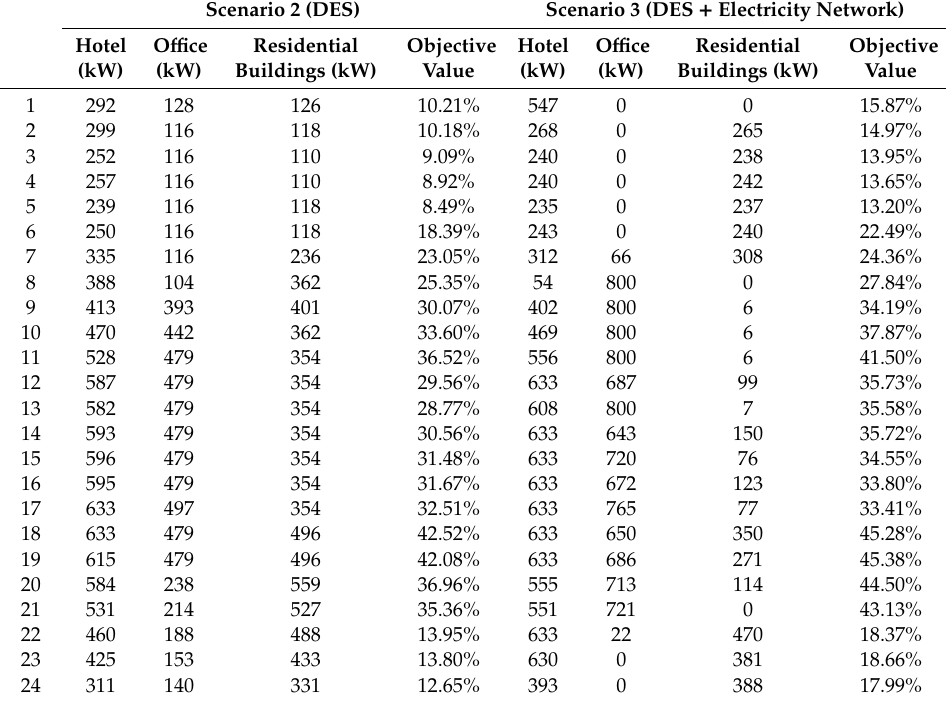
Table 7. The results of optimal system design of hourly energy demand in typical winter day.